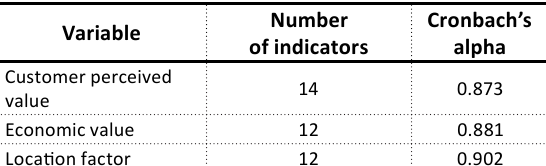
Table 2. Reliability analysis